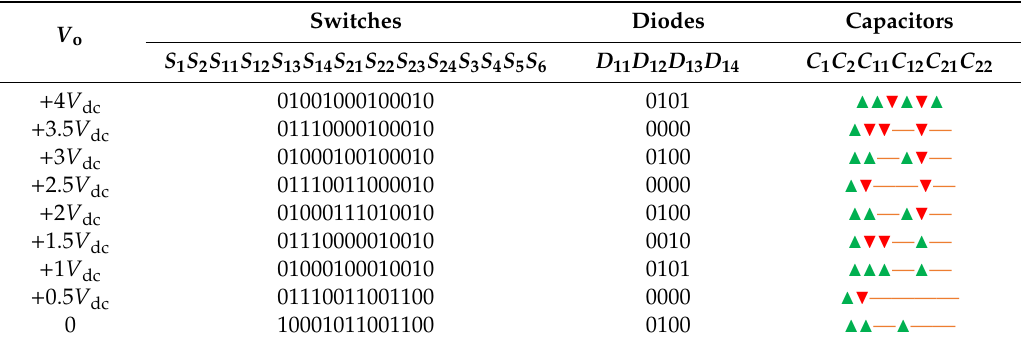
Table 4. Working state of devices in the 17-level inverter.